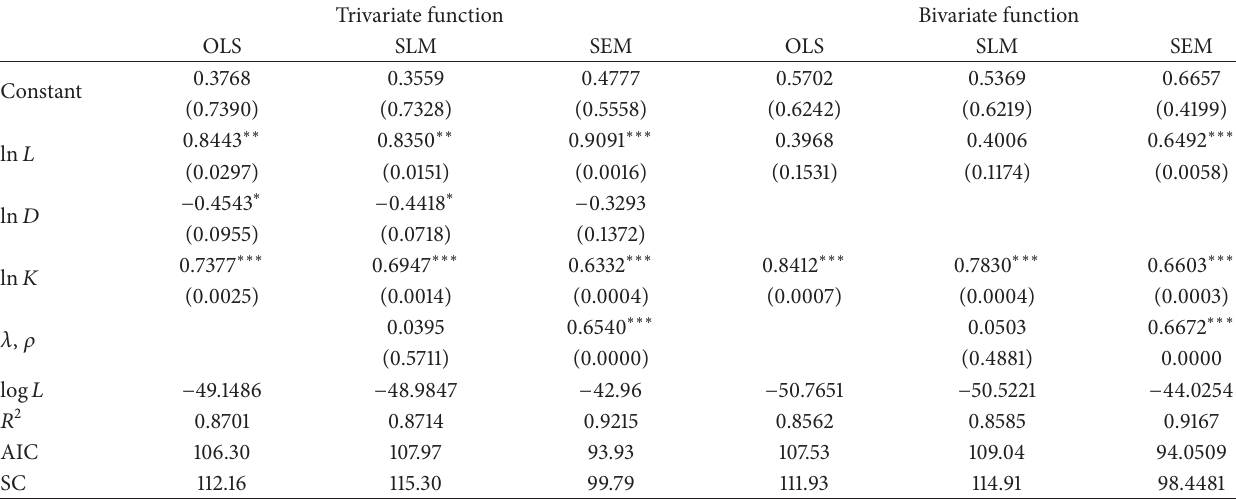
Table 4: Different regression models based on space weight matrix 𝑊 Queen 1